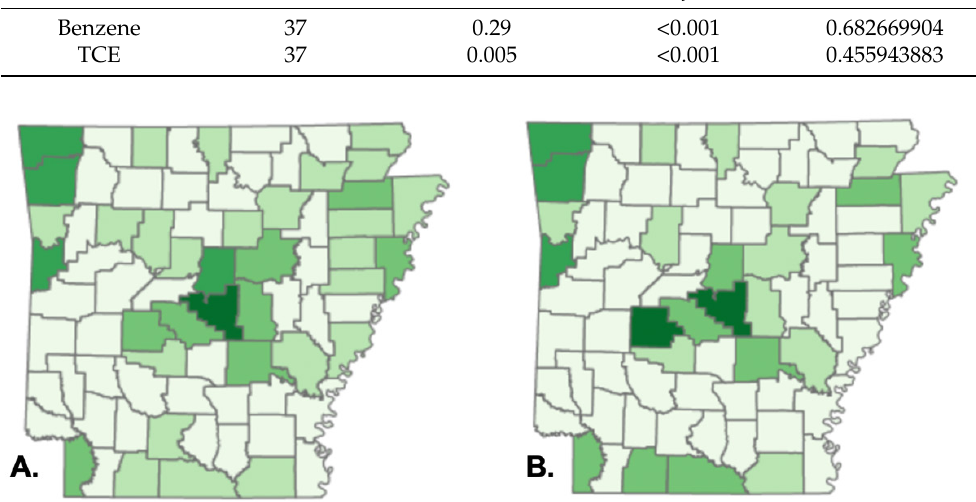
Figure 4. Ambient concentrations of benzene ( A ) and trichloroethylene ( B ) from the 2014 EPA National Air Toxics Assessment. Table 7. Estimates of the linear regression parameters for benzene and trichloroethylene (TCE).